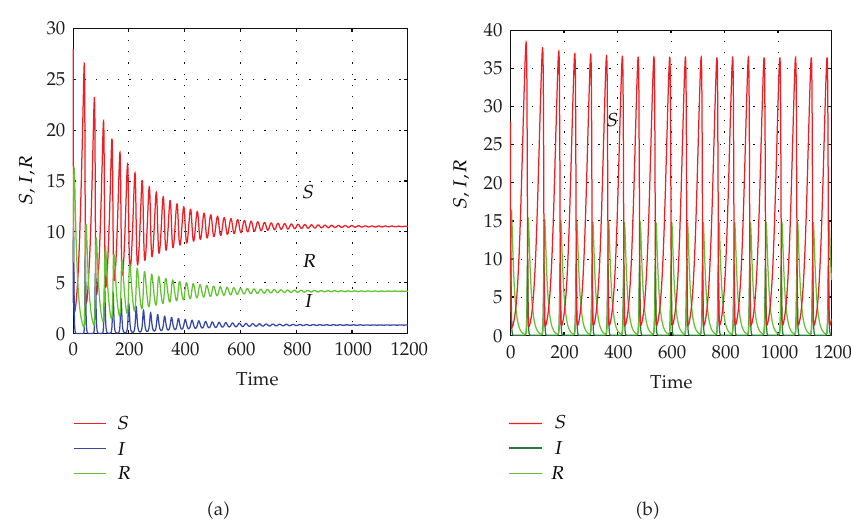
Figure 2: Solution of delayed SIR model (cid:3) 3.2 (cid:6) , when r (cid:7) 0 . 1, K (cid:7) 50, β (cid:7) 0 . 1, σ (cid:7) 0 . 005, a (cid:7) 0 . 5, α (cid:7) 0 . 5, (cid:7) 4 . 7 > R c (cid:7) 3 with time-lag τ (cid:7) 0 . 01 < τ ∗ (cid:3) a (cid:6) and τ (cid:7) τ ∗ (cid:7) 0 . 58 (cid:3) b (cid:6) that display δ (cid:7) 0 . 1, S ∗ (cid:7) 10 . 5, R 0 periodic outbreak of the disease due to a Hopf bifurcation when τ (cid:7) τ ∗ .